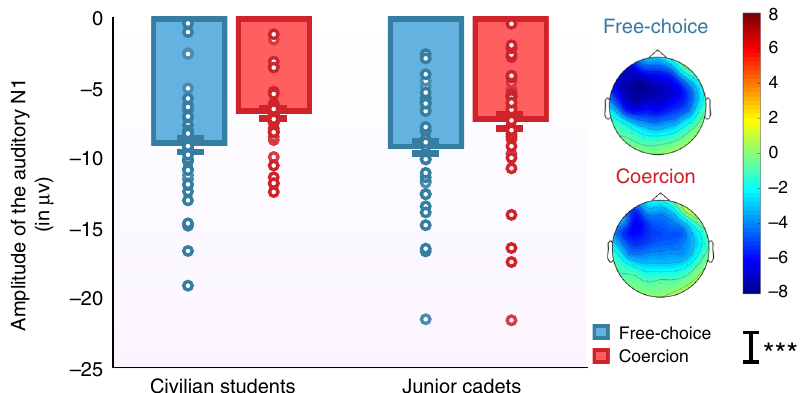
Fig. 2 Mean amplitude of the auditory N1 in both the free-choice (blue) and the coercion (red) conditions, respective to the Group (junior cadets – n = 36 vs. civilian students – n = 36). Data are presented as mean values± SEM. Errors bars represent standard errors. Graphical display showing the interaction Condition*Group in a mixed ANOVA with the main effect of Condition represented by a black signi fi cance line. All tests were two-tailed. *** represents a p -value < 0.001. Colored dots represent individual participant data. Source data are provided as a Source Data fi le.